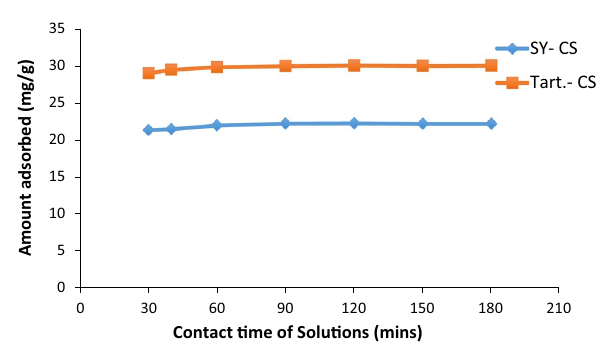
Fig. 7 Effect of contact time on the amount of sunset yellow and tar- trazine dyes adsorbed onto CS